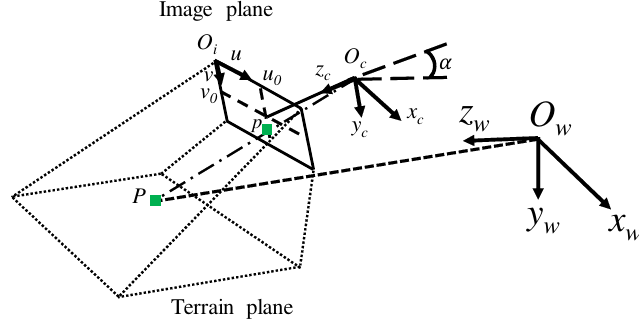
Figure 9. Camera frame for mapping 3D point mapping onto the image plane.